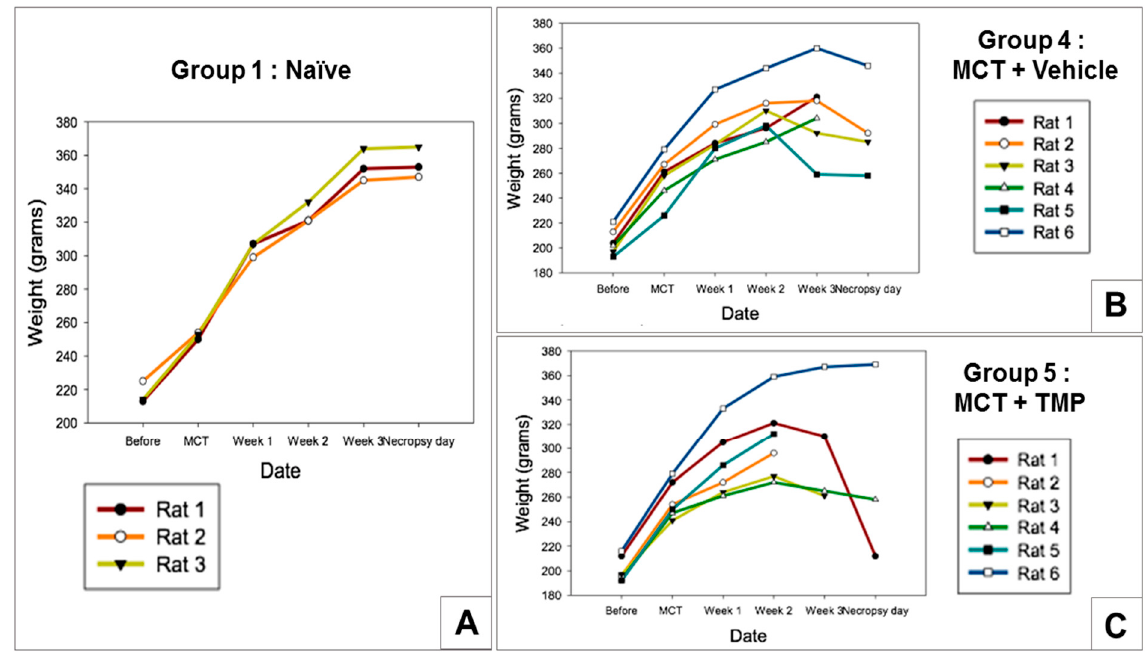
Figure 12. Body weights of rats measured weekly for: ( A ) Group 1; ( B ) Group 4; and ( C ) Group 5 from insufflator (dry powder aerosol) study.